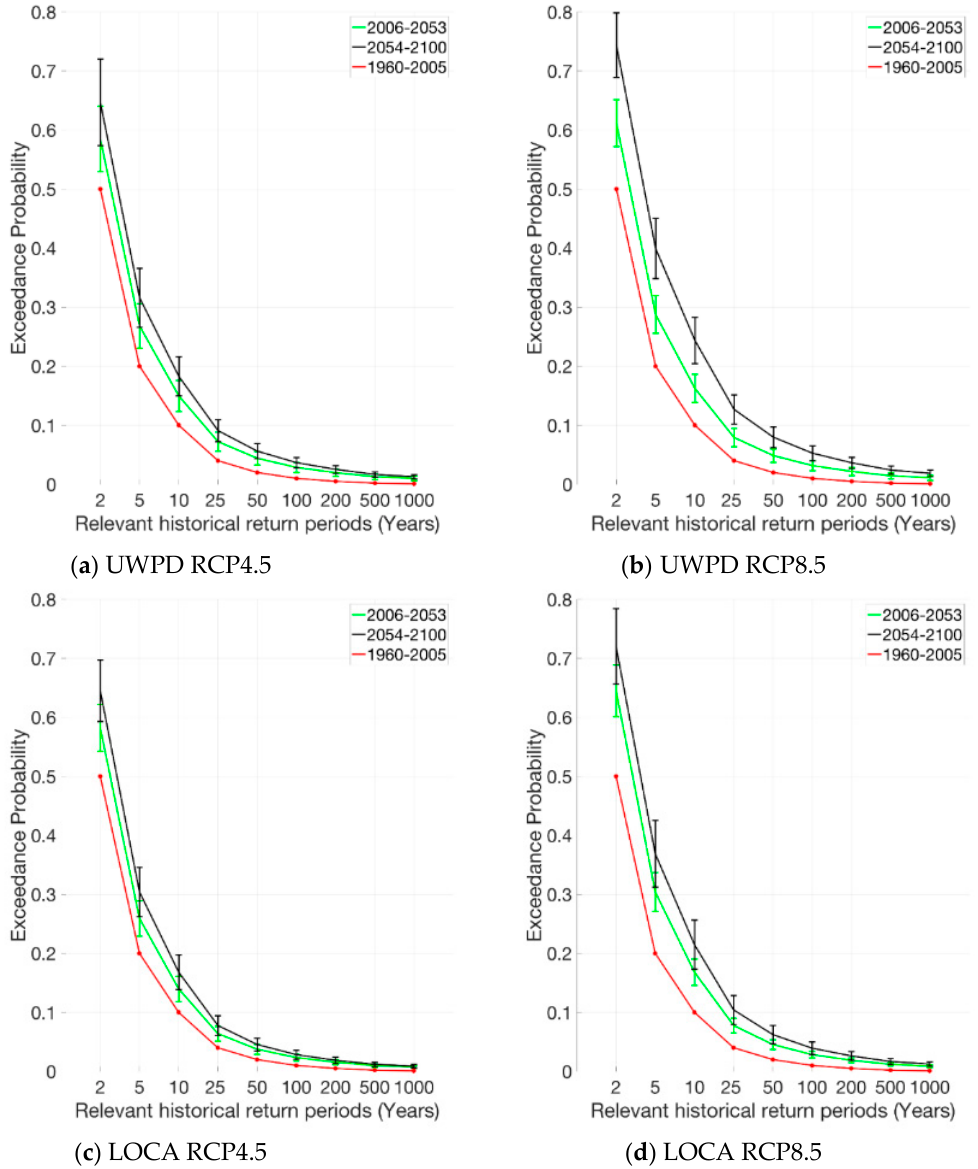
Figure 10. Northeastern US domain averaged exceedance probabilities (Equations (7) and (8)) for di ff erent relevant historical return periods (related to PF hist ) under di ff erent scenarios. Results for UWPD (upper; ( a ): RCP4.5; ( b ): RCP8.5) and LOCA (lower; ( c ): RCP4.5; ( d ): RCP8.5). The short vertical lines represent the uncertainties estimated by the ensemble spread. Red represents the results for the historical period (1960–2005), green for the first half of the 21st century (2006–2053), and black for the second half (2054–2100).